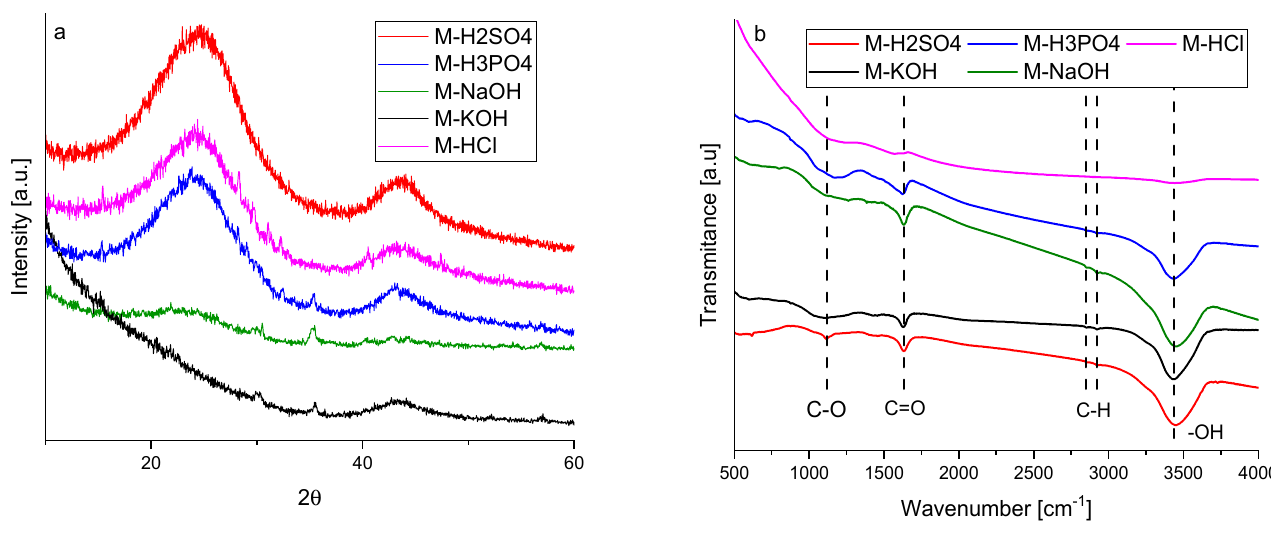
Figure 1. XRD diffraction patterns ( a ) and FTIR spectra ( b ) of the activated carbons produced from molasses. Table 1. Structural parameters of activated carbons obtained from XRD, and I G /I D ratios calculated from Raman